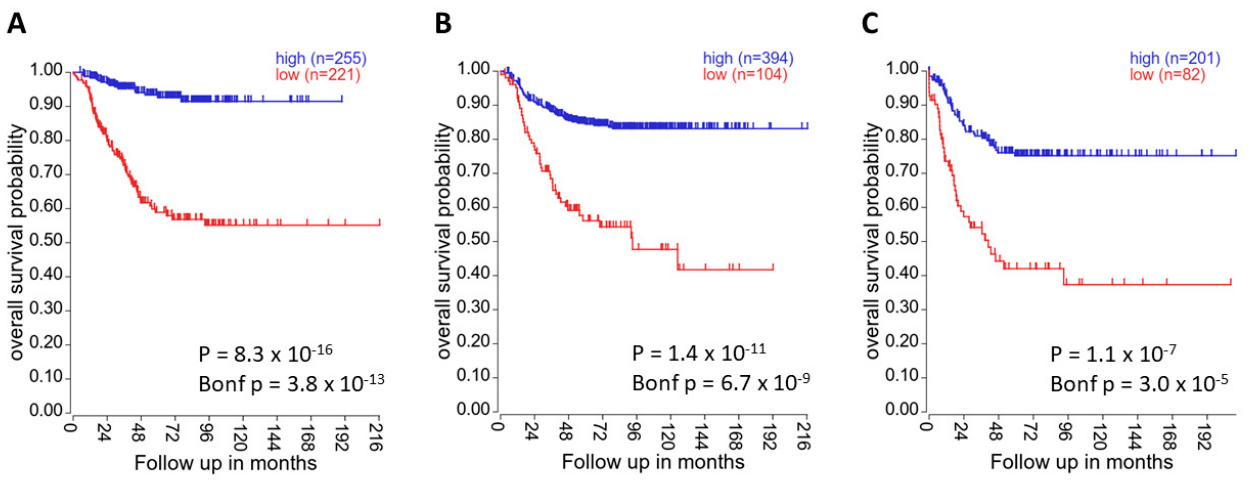
Figure 5. High DUSP26 expression correlates with increased patient survival. In ( A ) the “Kocak-649-custom-ag44kcwolf” dataset, ( B ) the “SEQC-498-RPM-seqcnb1” dataset and ( C ) the “NRC-283-rma_sketch-(bc)-huex10t” dataset, DUSP26 mRNA expression was significantly associated with overall patient survival (all p < 0.05). Kaplan–Meier survival curves were generated using the KaplanScan method presented on the R2 online platform [75] .